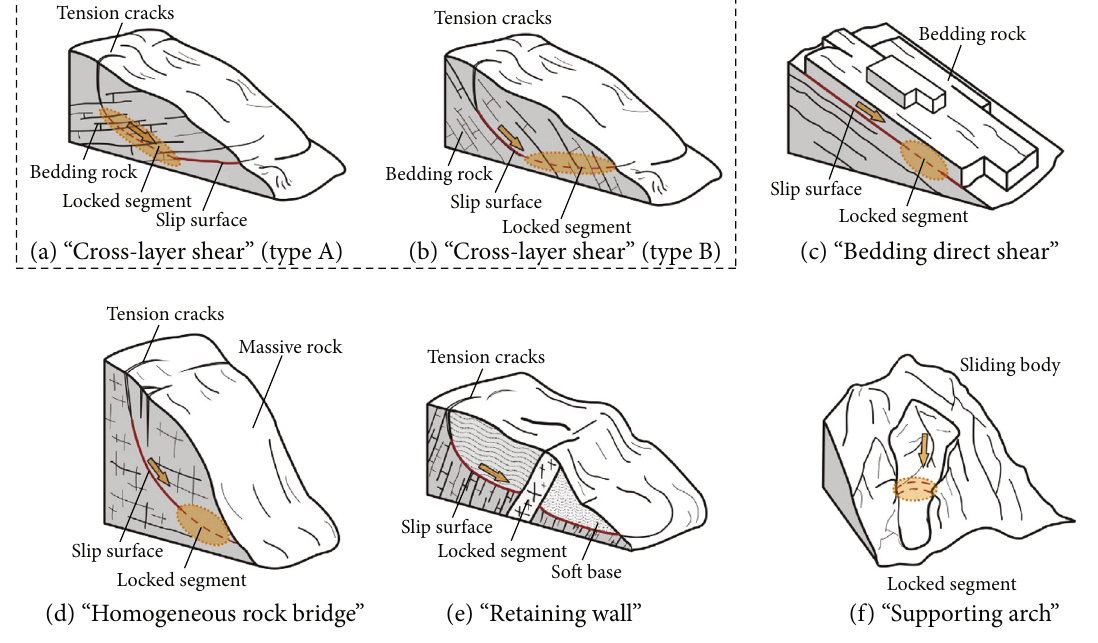
Figure 1: Classi fi cation of the locked-segment type landslides